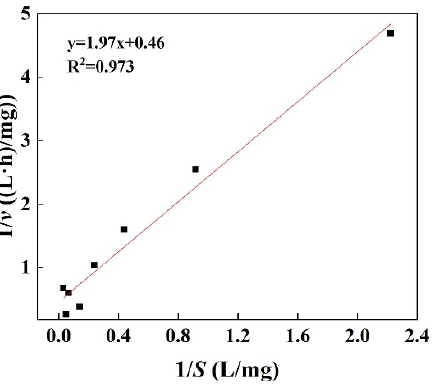
Figure 12. Fitting results of denitrification experimental data with Monod model.